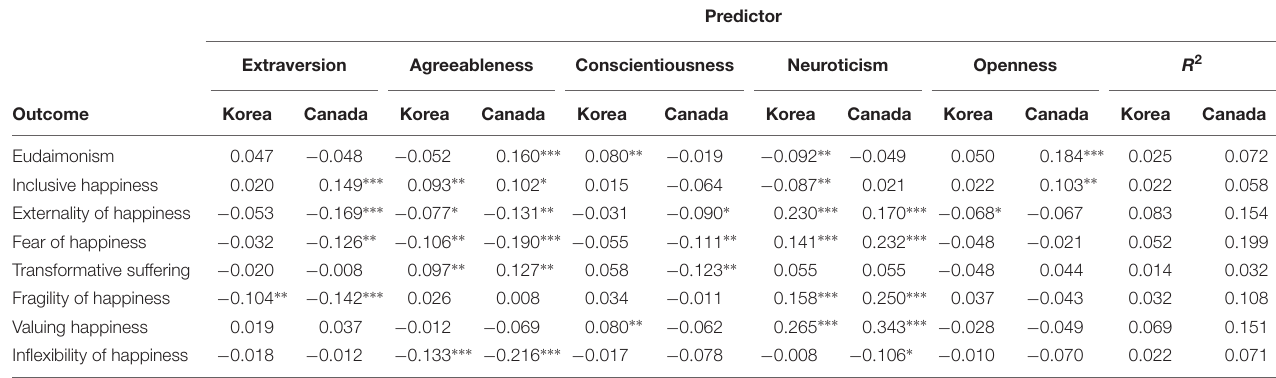
TABLE 4 | The Big Five predicting conceptions of happiness (standardized regression